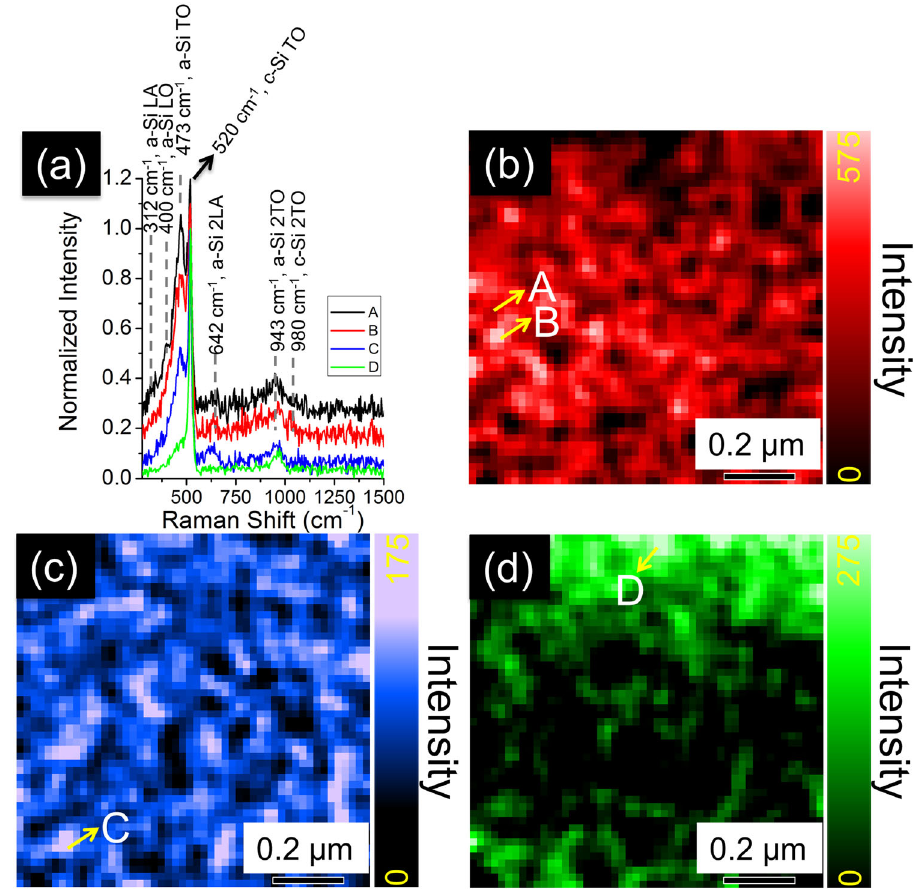
Fig. 2 TERS spectra from selected locations and TERS mappings based on a single peak. a The tip-enhanced Raman spectroscopy (TERS) spectra collected from various locations on the amorphous silicon a-Si surface labeled by “ A ” to “ D ” in ( b – d ). TERS mapping of an individual peak intensity centered at ( b ) 473 cm -1 (a-Si transvers optical or TO mode), ( c ) 642 cm -1 (2nd-order longitudinal acoustic or 2LA mode), and ( d ) 943 cm − 1 (2TO mode). A hybrid TERS mapping combining the peak intensity distribution in ( b – d ) is shown in Fig. S2. The color bar scales the single peak intensity for each TERS